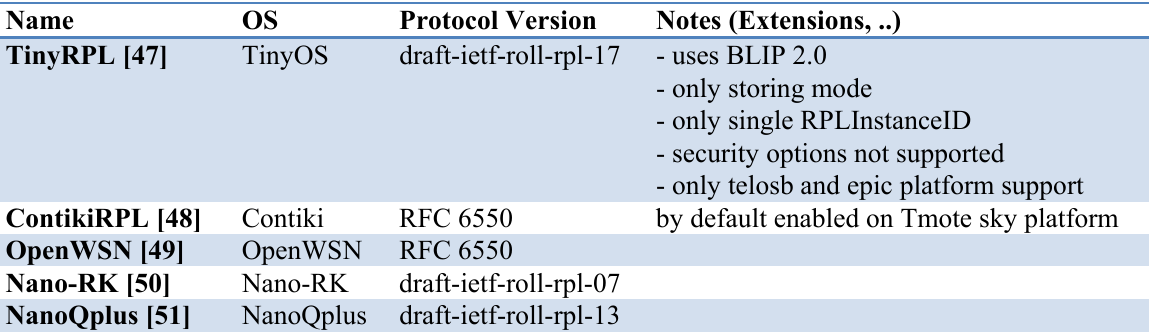
Table 5. Implementations incorporating RPL.